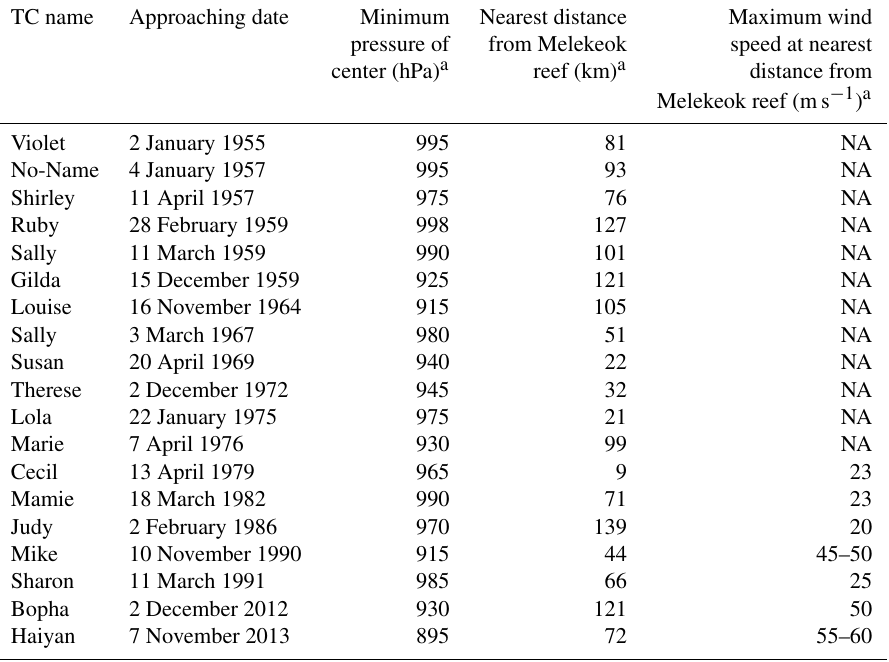
Table 1. Tropical cyclone passing within 150km of Melekeok reef from 1951 to 2015. TC